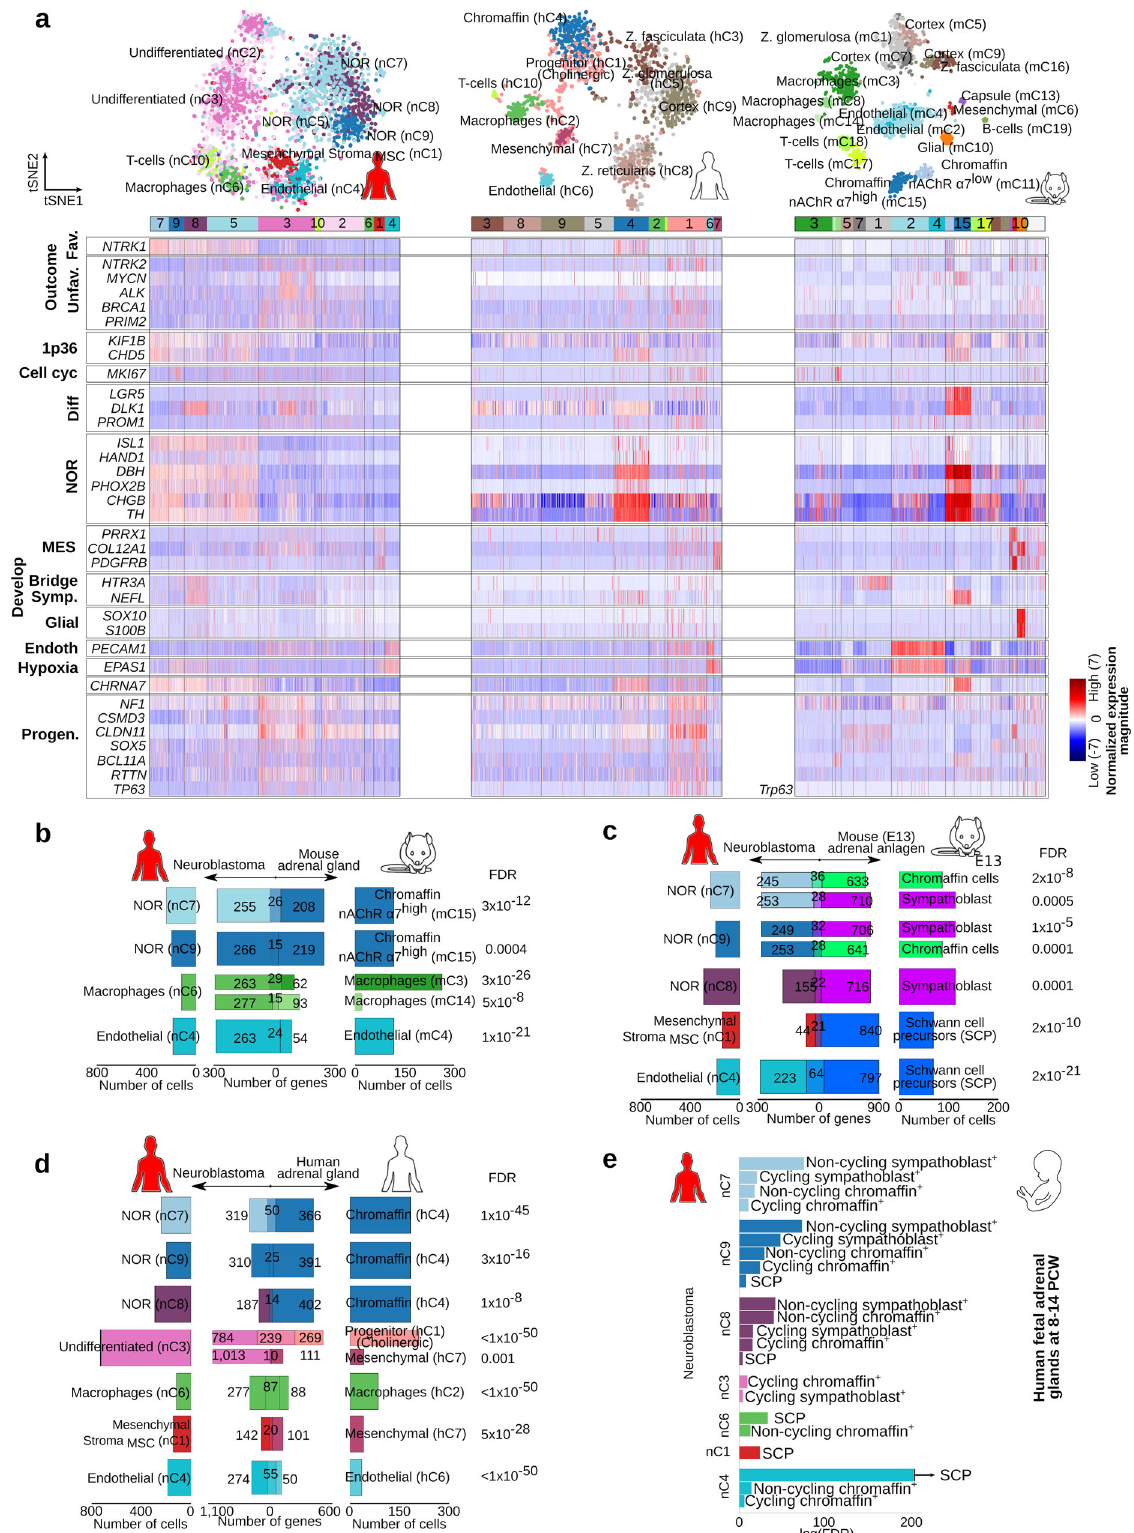
clusters (FDR = 5.45 × 10 − 18 and FDR = 1.08 × 10 − 18 , respectively, Fisher ’ s exact test, Fig. 5e, Supplementary Data 8). A comparative analysis with the mouse embryonic transcriptional pro fi les showed signi fi cant gene signatures shared between NOR nC7 and nC9 clusters with both, mouse embryonic chromaf fi n and sympathoblast